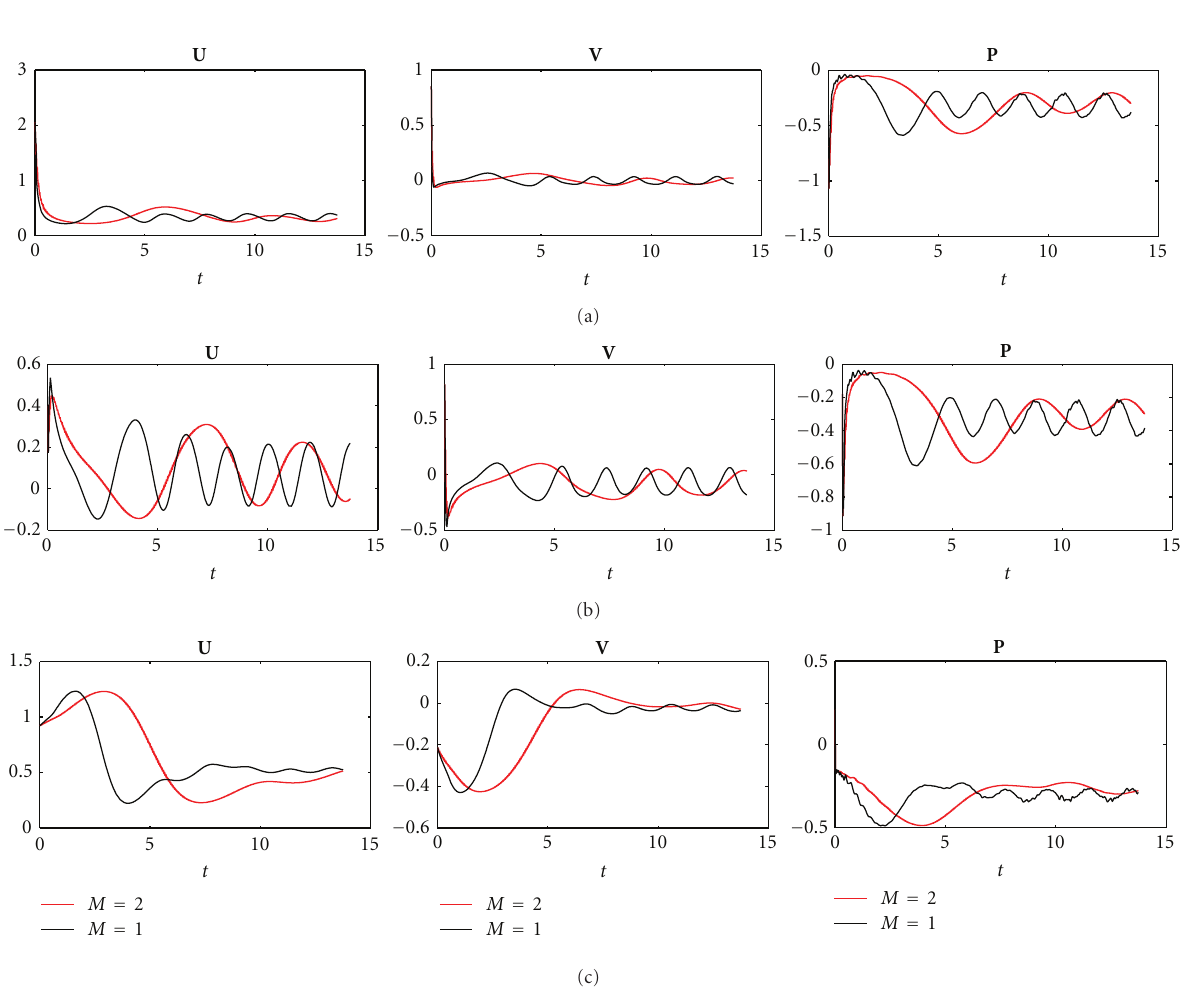
Figure 14: Time series plot of the primary variables. From top to bottom: Probes #1, #2, and